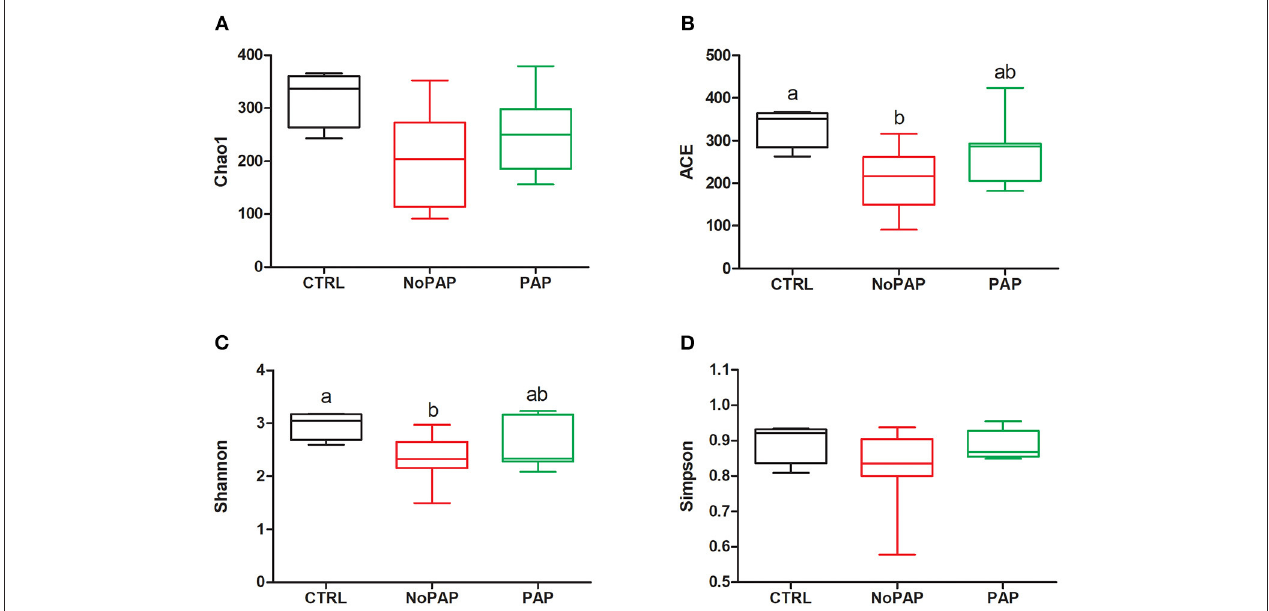
FIGURE 1 | Box plots representing the mean (min-max) of richness estimates [ (A) Chao1 and (B) ACE] and diversity indexes [ (C) Shannon and (D) Simpson] of the intestinal microbial populations found in fish fed with the CTRL ( n = 4), non-PAP ( n = 9), and PAP ( n = 7) diets. Different letters indicate significant differences among the groups (Kruskal–Wallis with Dunn’s post-test, P <